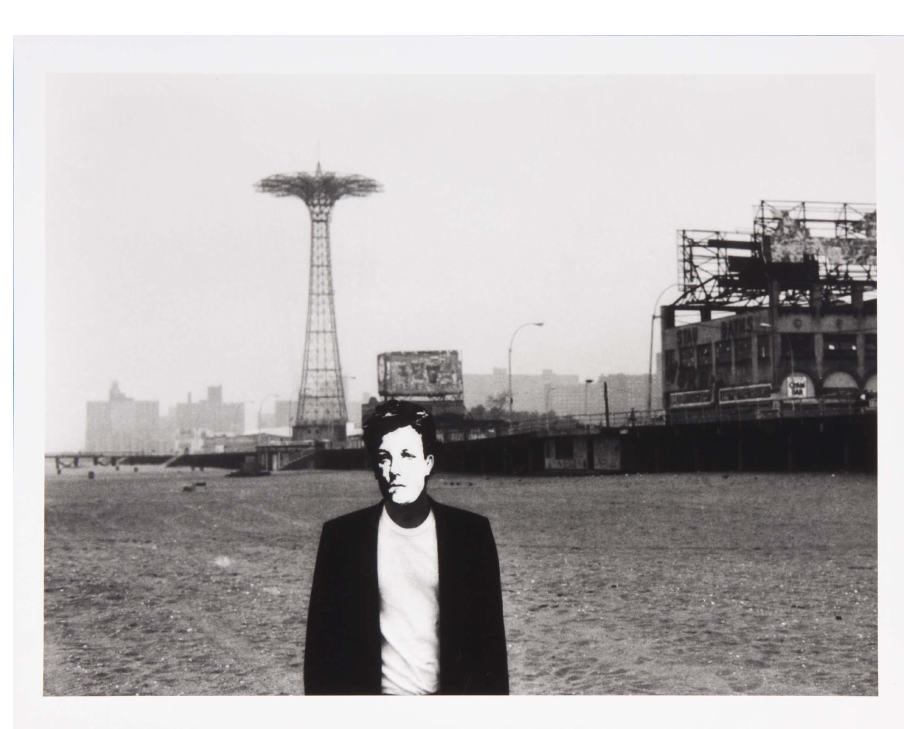
Figure 5: Arthur Rimbaud in New York (Coney Island) , David Wojnarowicz, 1978- 79, silver print. Courtesy of the Estate and David Wojnarowicz and P·P·O·W, New